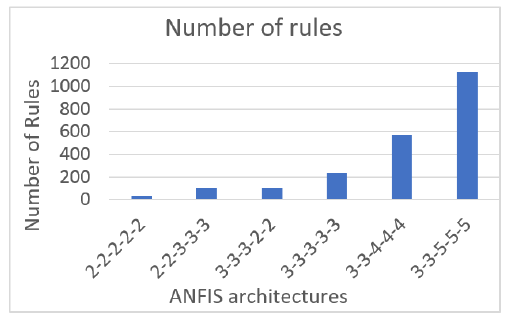
Figure 8. Number of rules for various ANFIS architectures.